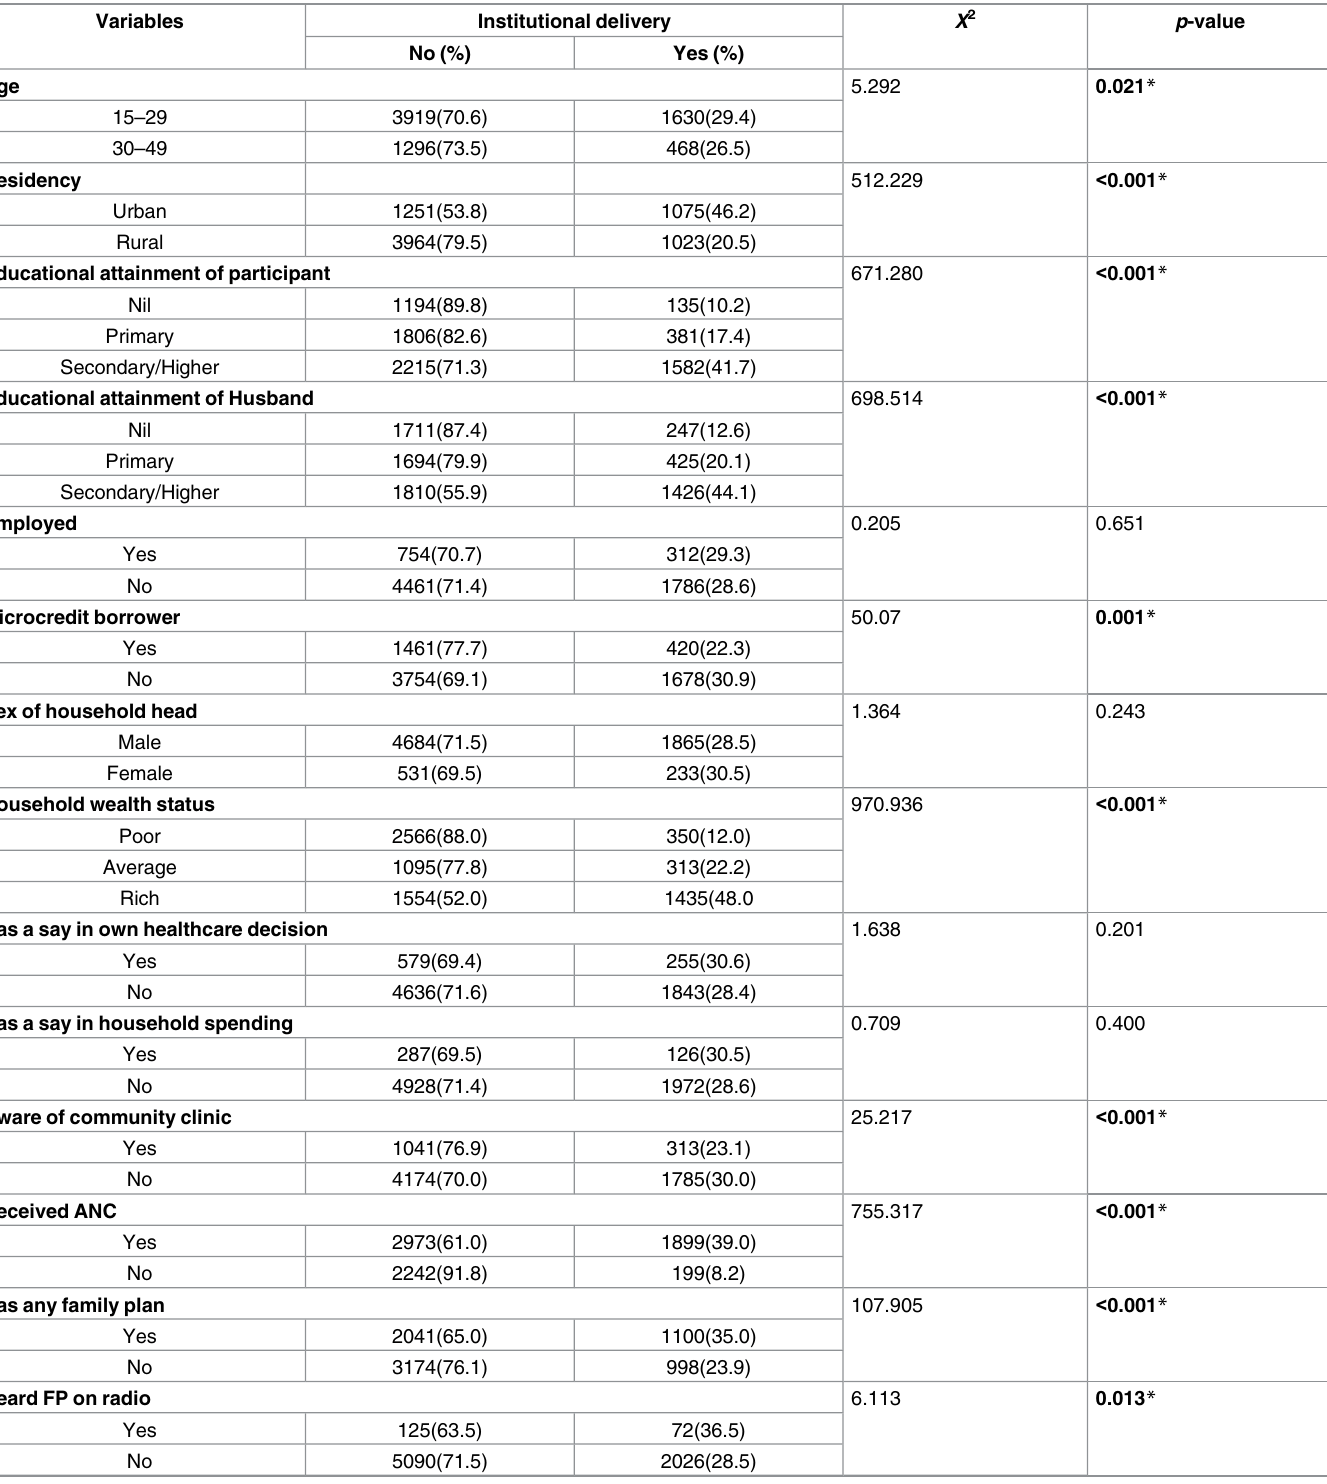
Table 2. Relative percentage of participants utilizing institutional delivery servicesacross the explanatory variable groups, BDHS